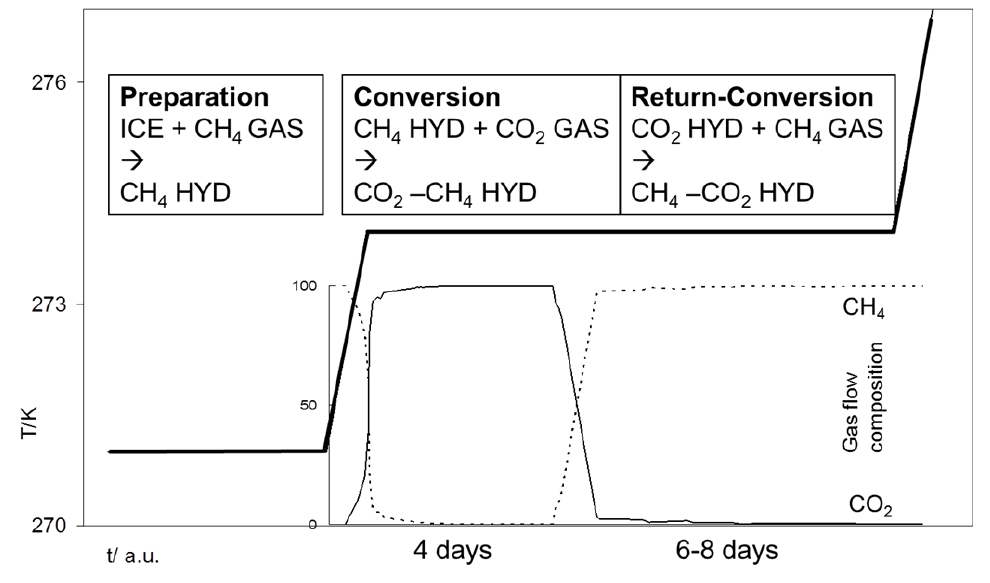
Figure 1. Schematic illustration of the experimental process, subdivided into preparation, conversion and return-conversion. Temperatures versus time as well as gas composition (in %) are exemplarily shown for the CH